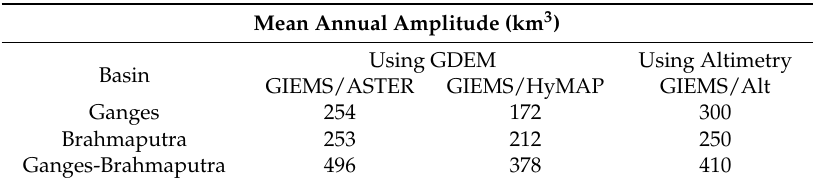
Figure 7. Monthly basin-scale SWS variations estimated using the GIEMS/GDEM approach (blue for ASTER and red for HyMAP), by the GIEMS/Altimetry technique (green) and total water storage (TWS) variations estimated using Gravity Recovery And Climate Experiment (GRACE) for the period 2003–2007 over: ( a ) Ganges; ( b ) Brahmaputra, and ( c ) Ganges-Brahmaputra River basins. Table 1. Mean annual amplitudes of SWS variations estimated by GIEMS/GDEM and GIEMS/Altimetry techniques over the G, B, and GB system. Mean Annual Amplitude (km 3 )